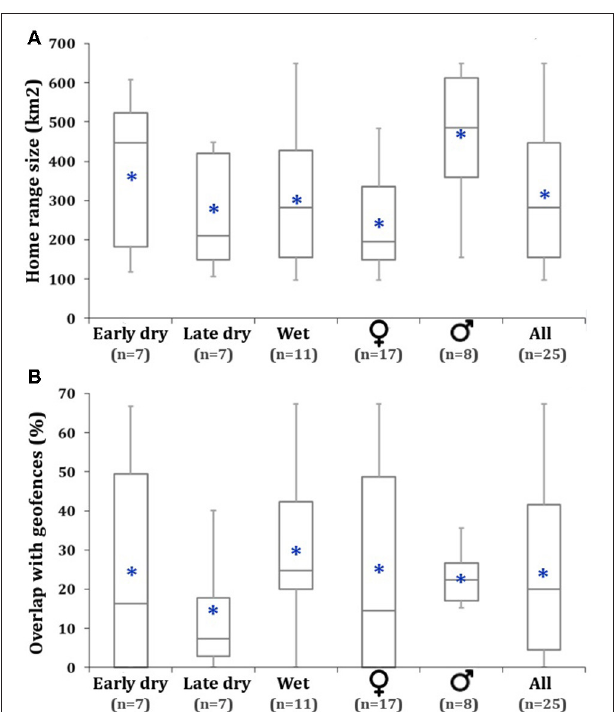
FIGURE 4 | Comparison of 100% Minimum Convex Polygon lion home range size (A) and percentage home range overlap with geofenced community areas (B) by season and genders. Blue asterisks show mean values. Sample sizes are shown in parentheses. The early dry season lasted from May to August, the late dry season from September to December, and the wet season from January to April. 100% MCPs were only calculated for individuals with sufficient GPS data ( > 60 days).